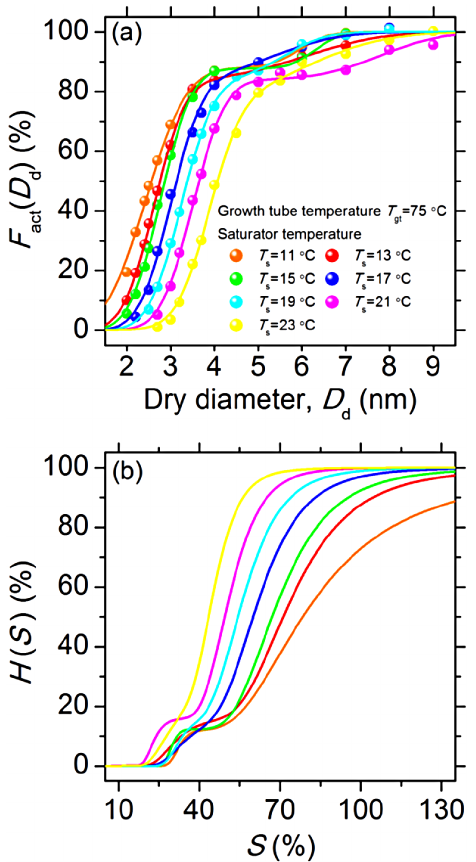
Figure 6. (a) Detection efficiencies of the SS-CPC (filled symbols) for WOx particles. The water-based CPC 3788 was operated with a constant temperature of growth tube ( T gt ) and the varied tem- peratures of the saturator ( T s ) . The different colored lines are fits of a bimodal lognormal cumulative Gaussian distribution function (Eq. 9) to the experimental points, corresponding to the different T s . (b) Cumulative supersaturation distribution H(S) inside CPC retrieved from the activation curve F act (D d ) based on Eq. (2). The colored solid lines indicate the different T s , which are in line with panel (a)